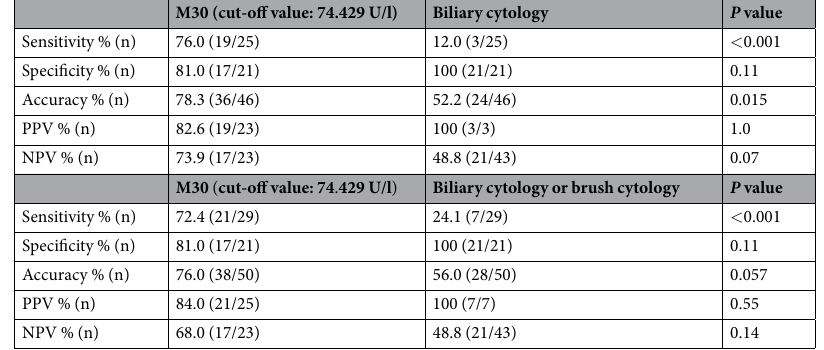
Table 4. Comparison of the malignant diagnosability of M30 and biliary cytology. PPV , positive predictive value; NPV , negative predictive value.